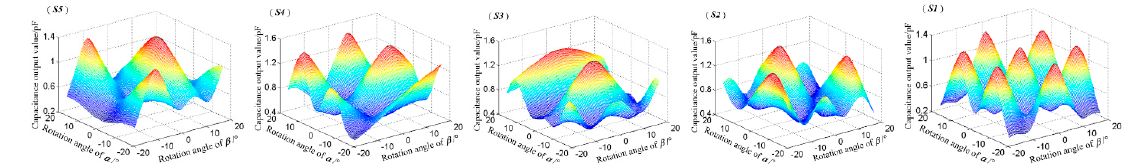
Figure 7. Capacitance output value distribution chart of Sensors 1–5.